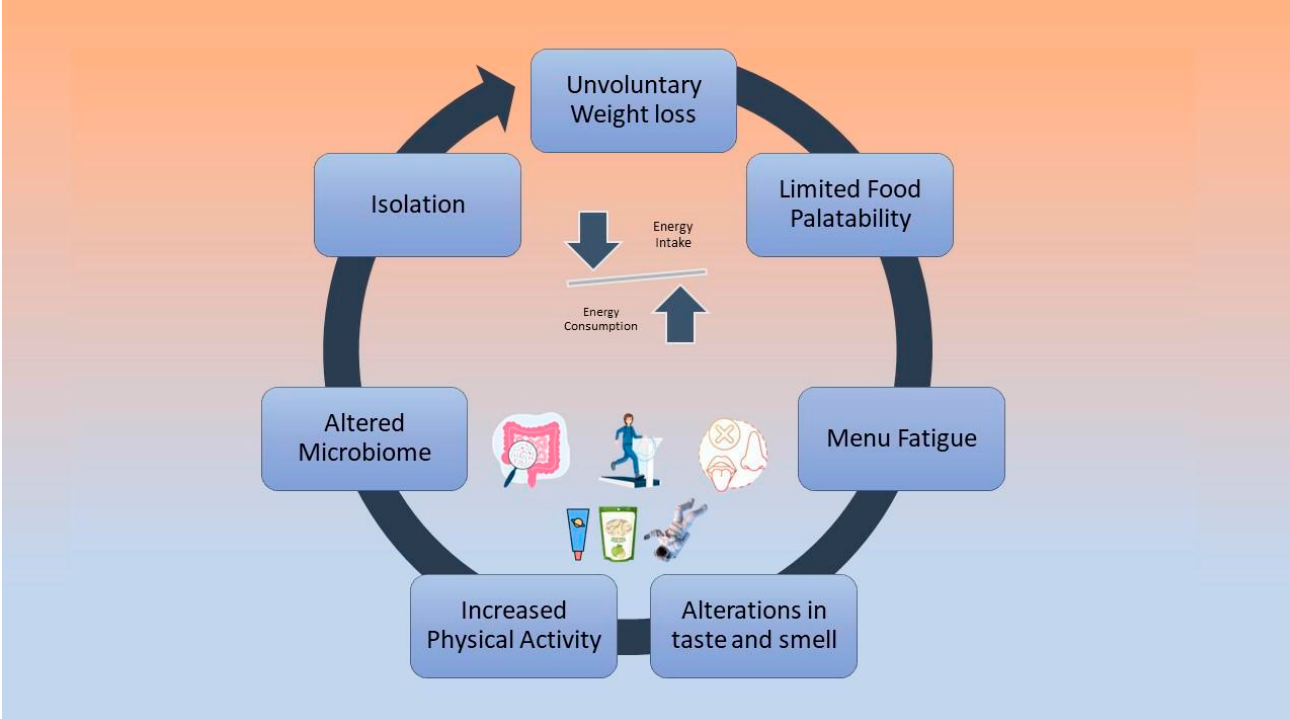
Figure 1. Causes of negative energy balance during spaceflights.